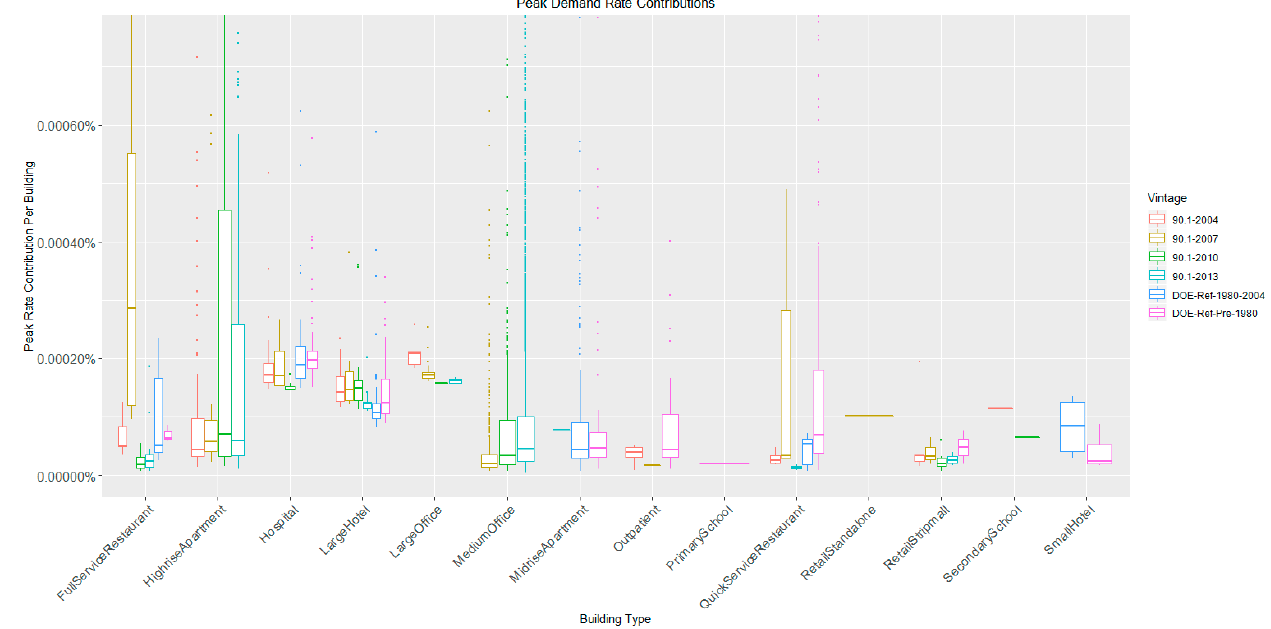
Figure 2. Box-and-whisker plot indicates statistical distribution of each building’s contribution to the utility’s twelve monthly peak hours added together, broken down by building type and vintage.